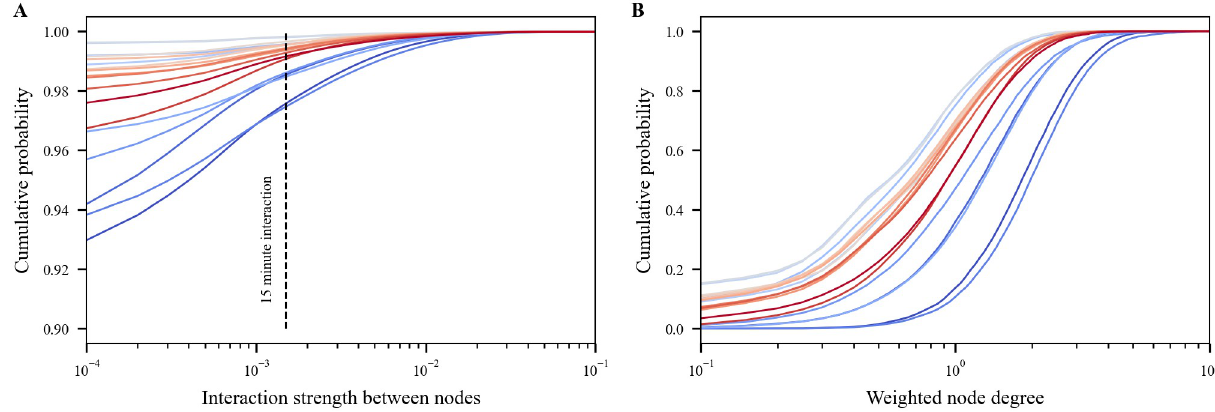
Fig 7. Interaction strength and weighted node degree distributions. The colorscale changes for each week, from February 10th (dark blue) to June 8th (dark red). A: Interaction strength between nodes, κ i , j . B: Weighted node degree, κ i .